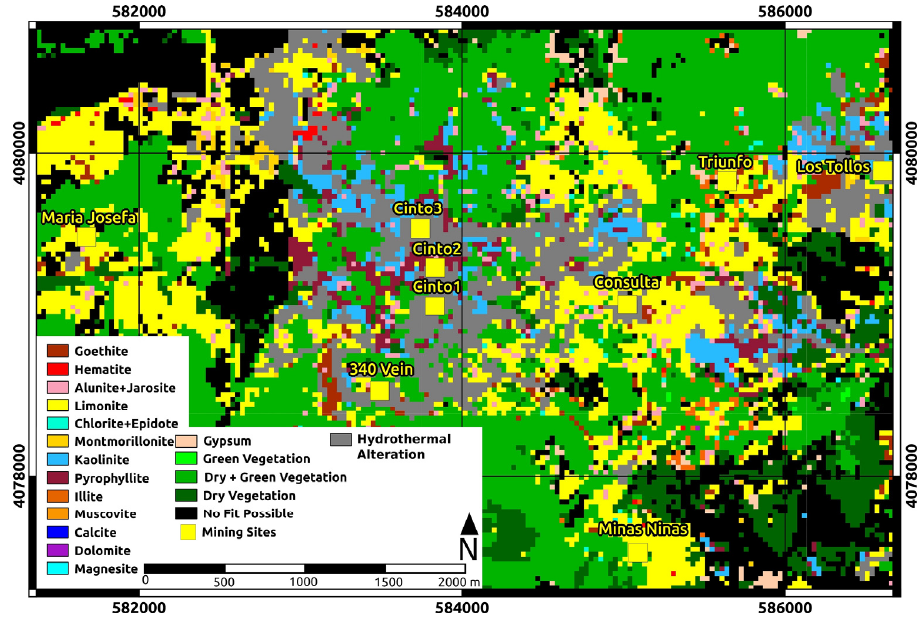
Figure 18. Location of the advanced argillic alteration centers, shown as grey opaque overlay, calculated from simulated EnMAP data.